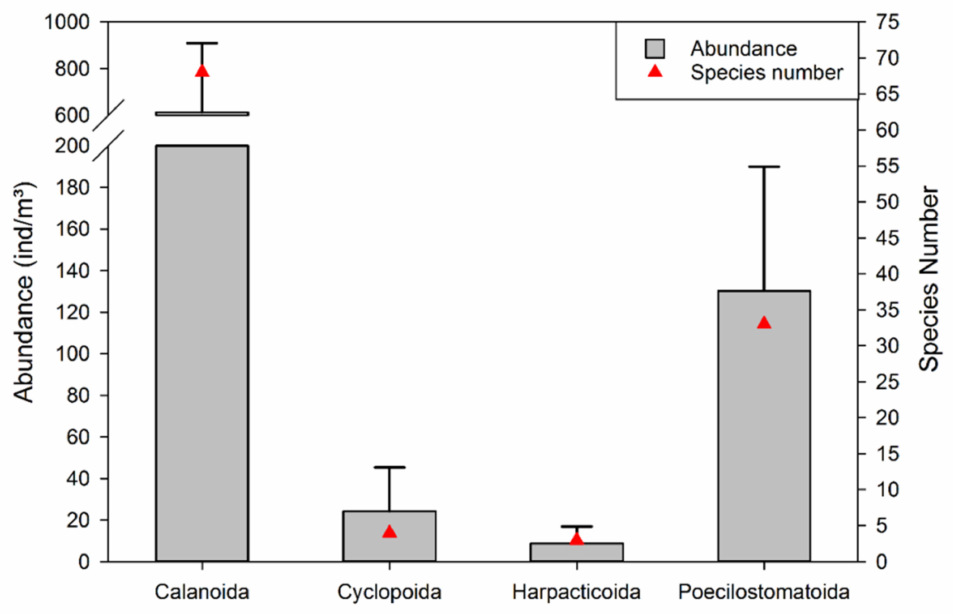
Figure 4. Species number and abundance composition in the research area during